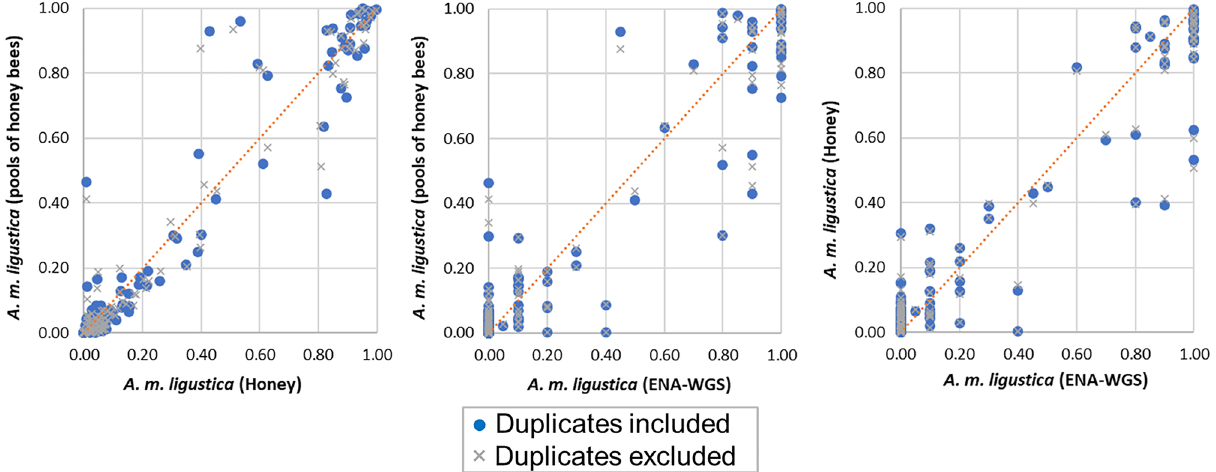
Figure 1. Scatter plots based on frequencies of the alternative allele of the 121 targeted Apis mellifera DNA markers. Data are related to the A. m. ligustica datasets and samples, for which multiple levels of information were available (larvae data are excluded but provided as Supplementary Fig. S2). Data are presented including/ excluding duplicate